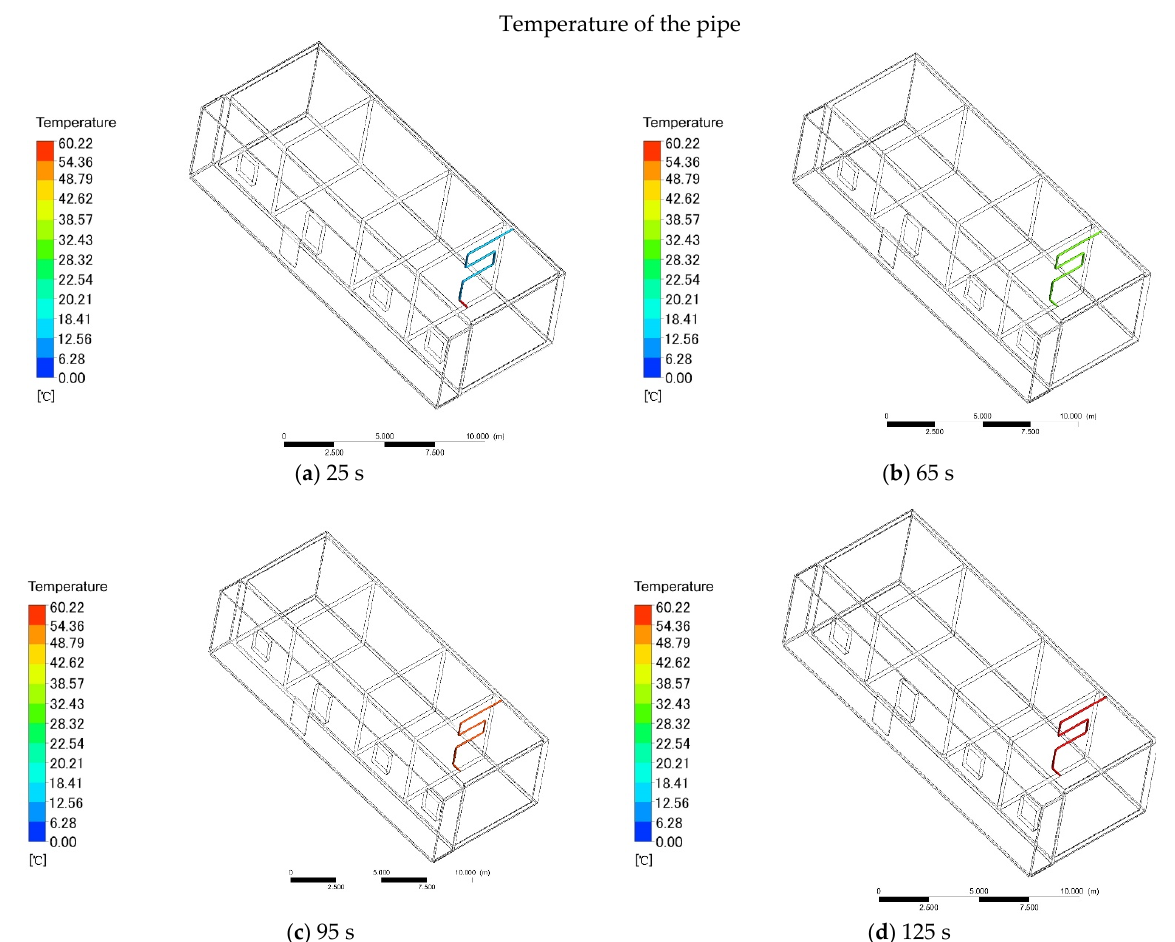
Figure 9. ( a ) Speed of the flue gas. ( b ) Pressure of the flue gas.